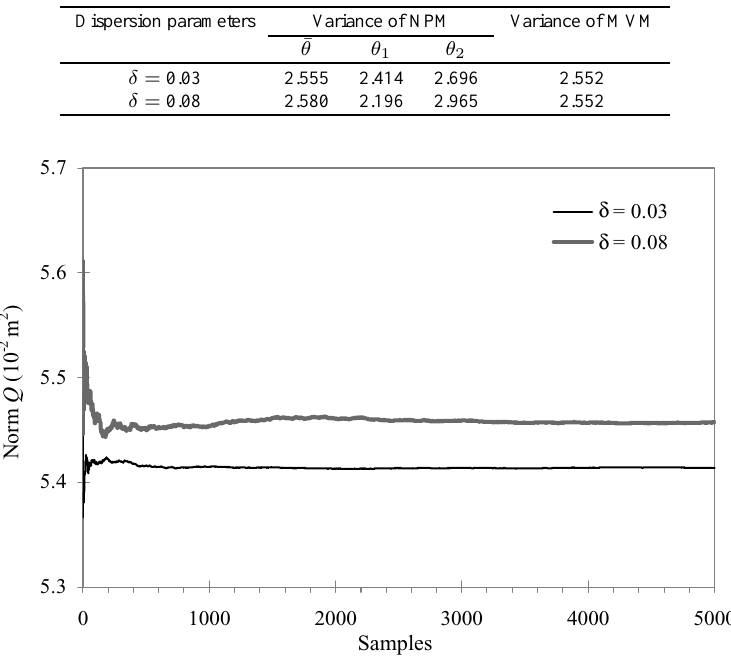
Fig. 2. Convergence analysis of Y 20 .